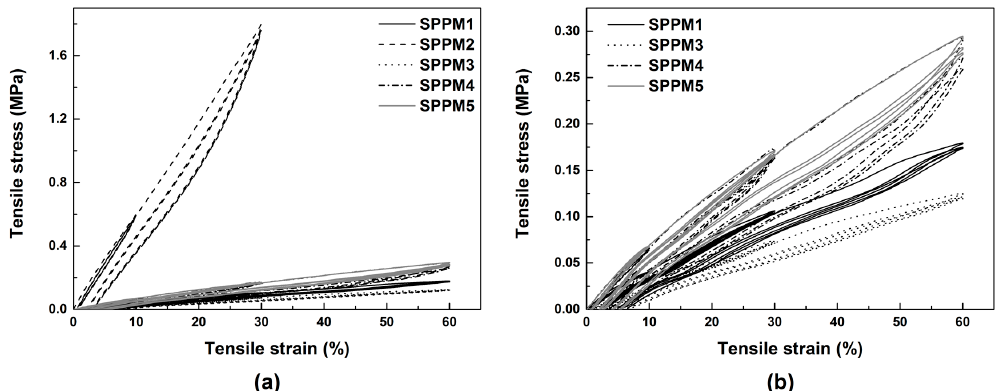
Figure 5. Typical stress vs. strain relationships under uni-axial cyclic tension at room temperature of all samples ( a ) and zoom-in view of all samples excluding SPPM2 ( b ). The stress vs. strain relationships of all samples during programming are presented in Figure 6.